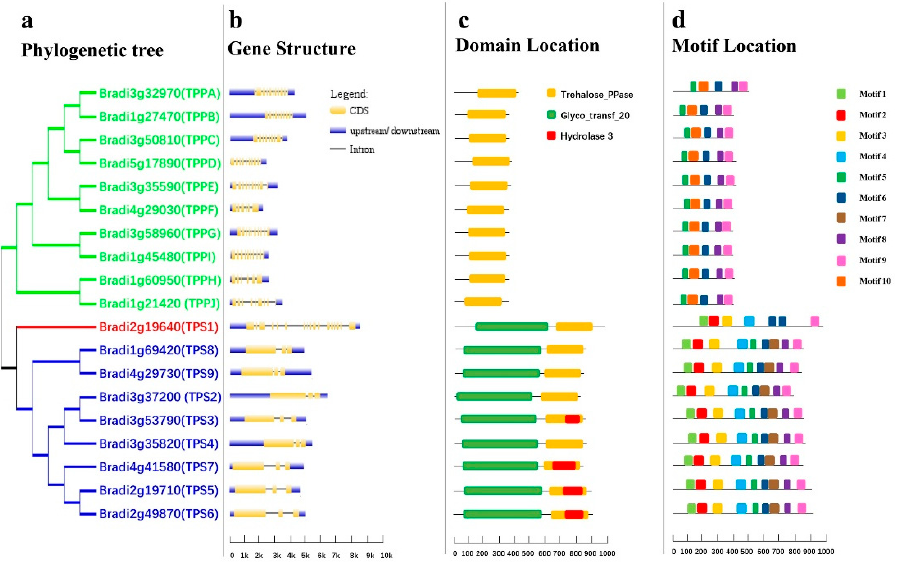
Figure 1. Phylogenetic relationships and gene structures, domains, and motifs of the BdTPS and BdTPP family. ( a ) Phylogenetic analysis, Class I, II, and III genes are shown in red, blue, and green, respectively. ( b ) Gene structure, introns, exons, and upstream/downstream regions are shown as straight lines and yellow and blue bars, respectively. ( c ) The conserved trehalose-6-phosphate synthase (TPS) domain (Glyco_transf_20), trehalose-6-phosphate phosphatase (TPP) domain (Trehalose_PPase), and haloacid dehalogenase-like hydrolase domain containing 3 (Hydrolase 3) are shown by yellow, green, and red, respectively. ( d ) Motif analysis, all motifs were identified by MEME tools, as shown in different bars.